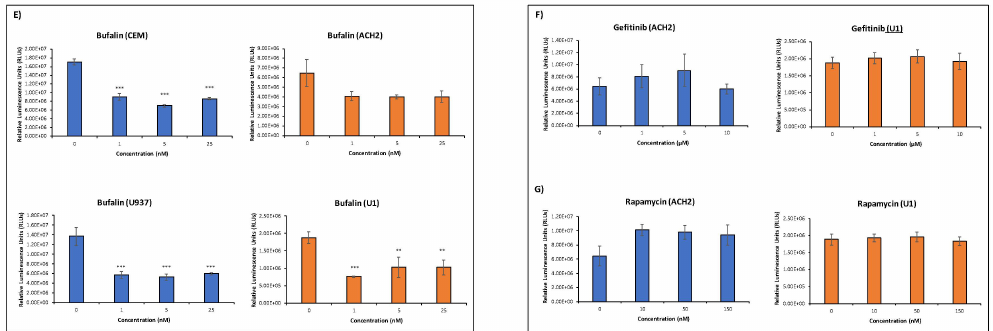
Figure 2. Inhibitor titration of uninfected and latent HIV-1-infected cells. In this process, 5 × 10 4 cells were plated with di ff erent concentrations of kinase inhibitors and allowed to incubate for 48 h prior